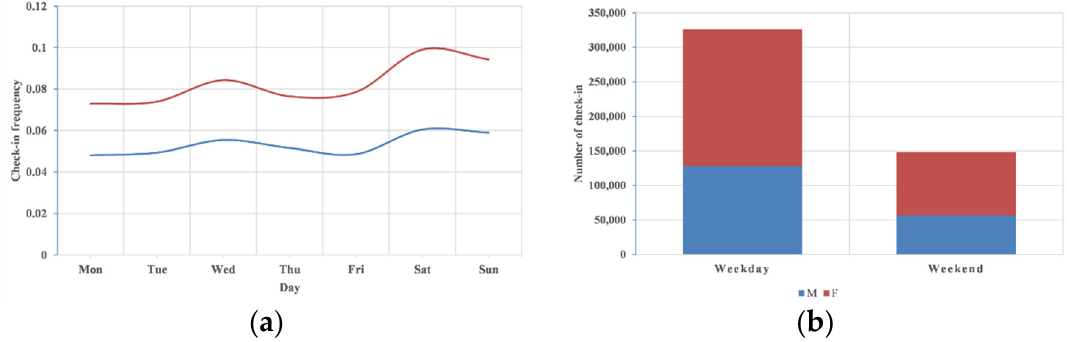
Figure 7. Check-in frequency of males and females during ( a ) a week, and ( b ) weekday and weekend.